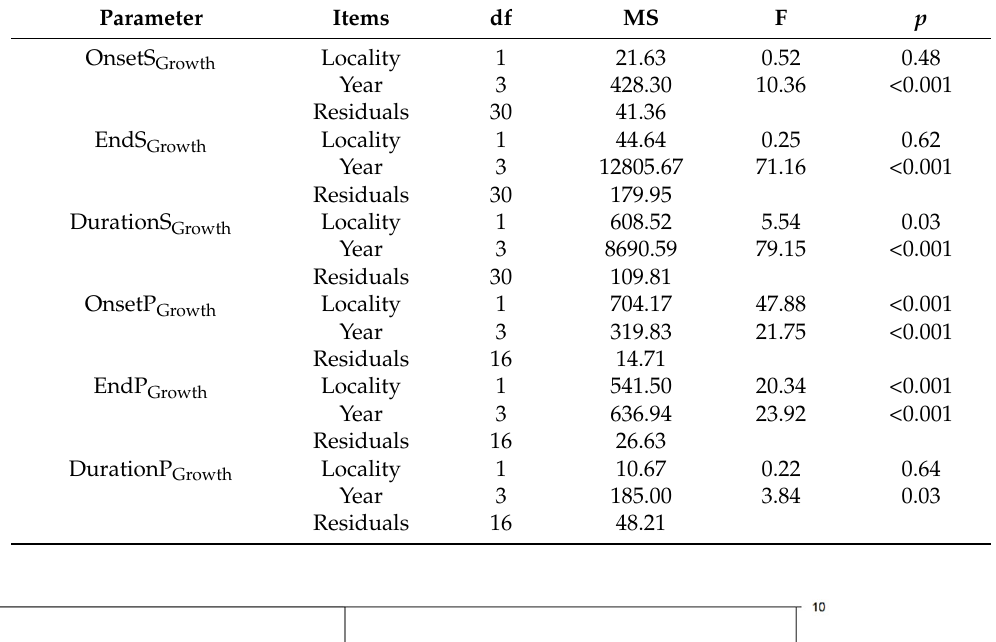
stem shrinking started at the end of August (DOY 180) and remained negative until the end of year. There was no growth detected after DOY 180. Table 2. The summary of general linear model for onset, end and duration of primary growth (P growth ) and secondary growth (S growth ) at ESP Rajec and Bily Kriz in different years (2016–2019).